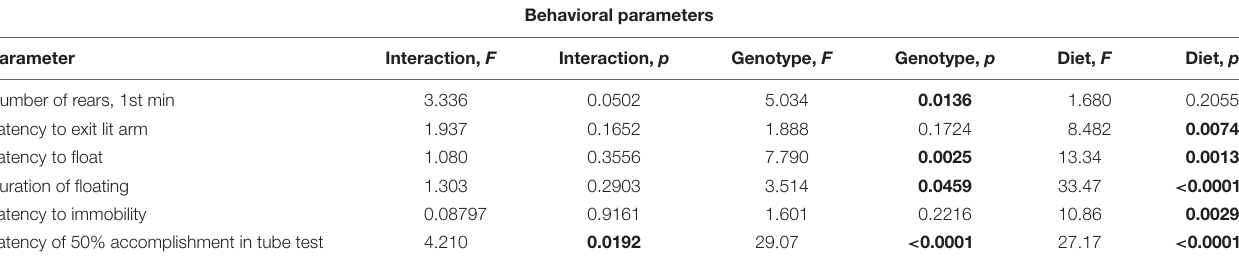
TABLE 4 | Two-way ANOVA results for statistical analysis of behavioral